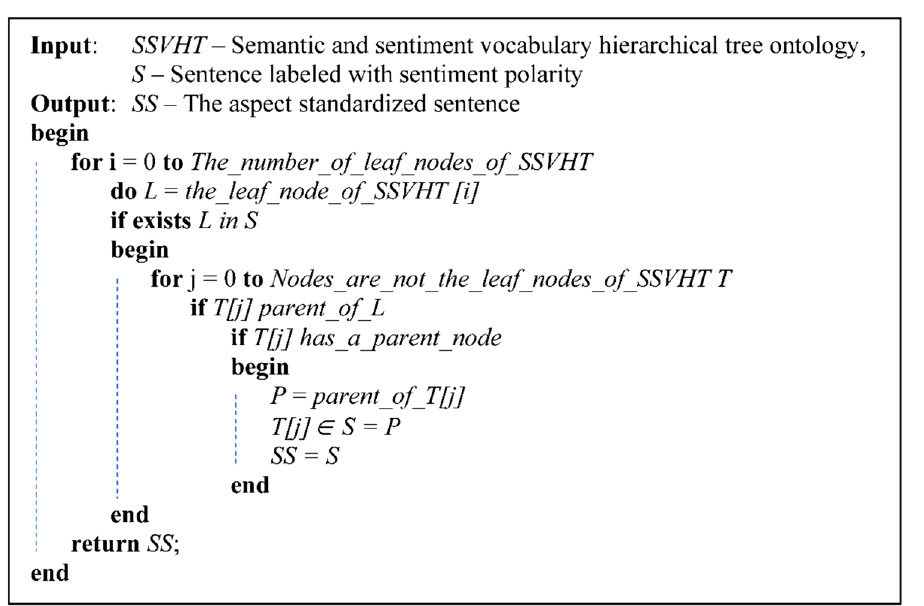
Figure 3. Algorithm of aspect standardization for the